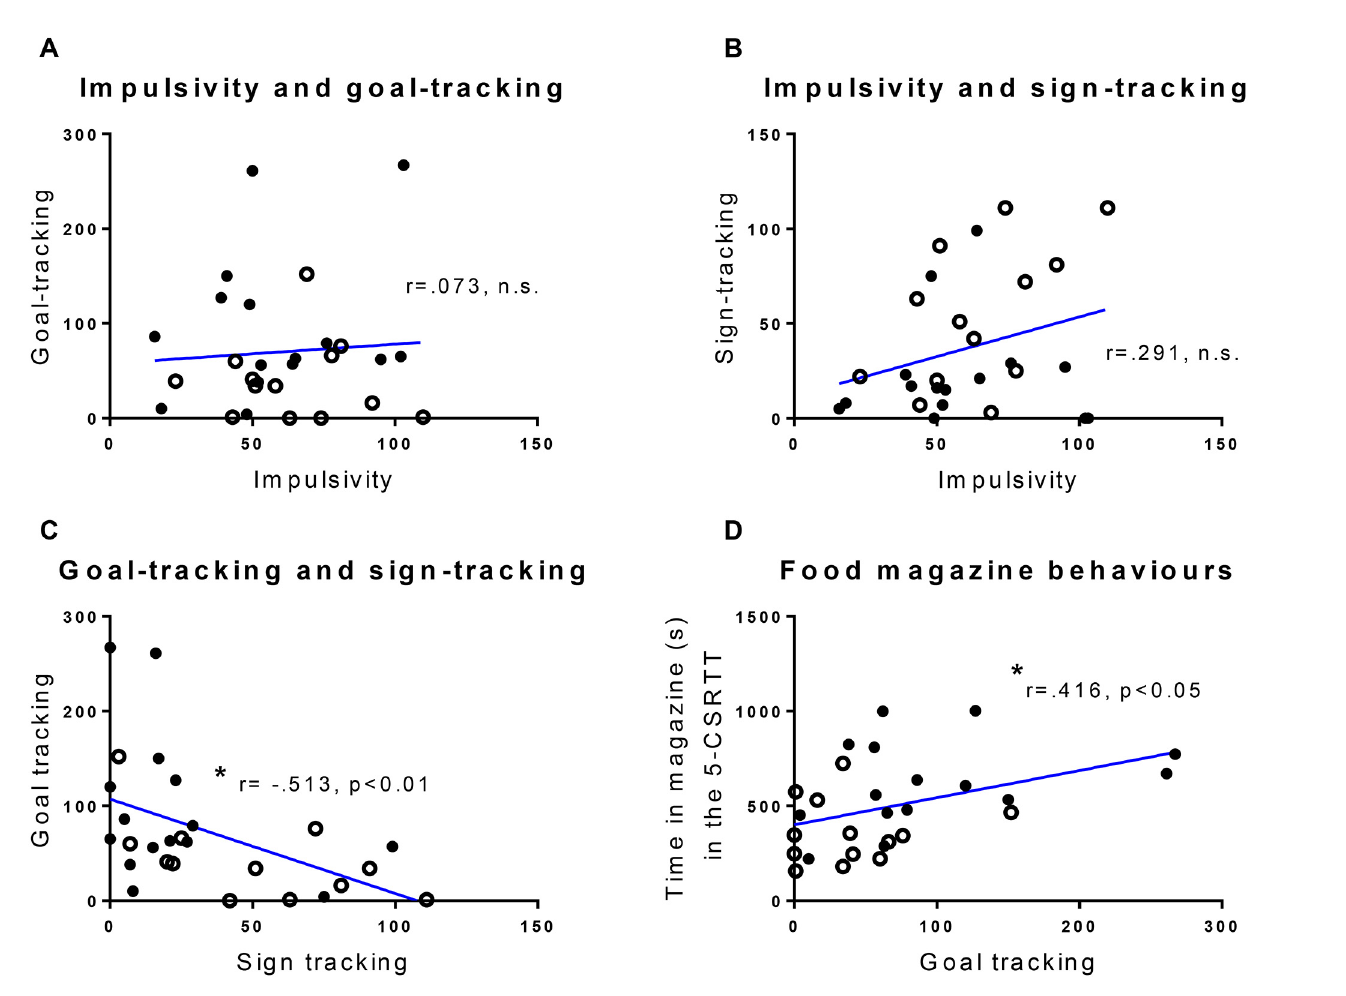
Fig 4. Correlations between main variables. Correlational analysis of impulsive responses during the first long ITI session in the 5-CSRTT and the data from the 5 th session of the Pavlovian conditioned approach task: Impulsivity and goal-tracking responses (number of magazine nose-pokes) (a); impulsive responses and sign-tracking responses (number of lever presses) (b); goal-tracking and sign-tracking responses (c); goal-tracking responses and time spent nose-poking in the food magazine during the first long ITI session in the 5-CSRTT) (d). P(closed circles), NP (open circles).